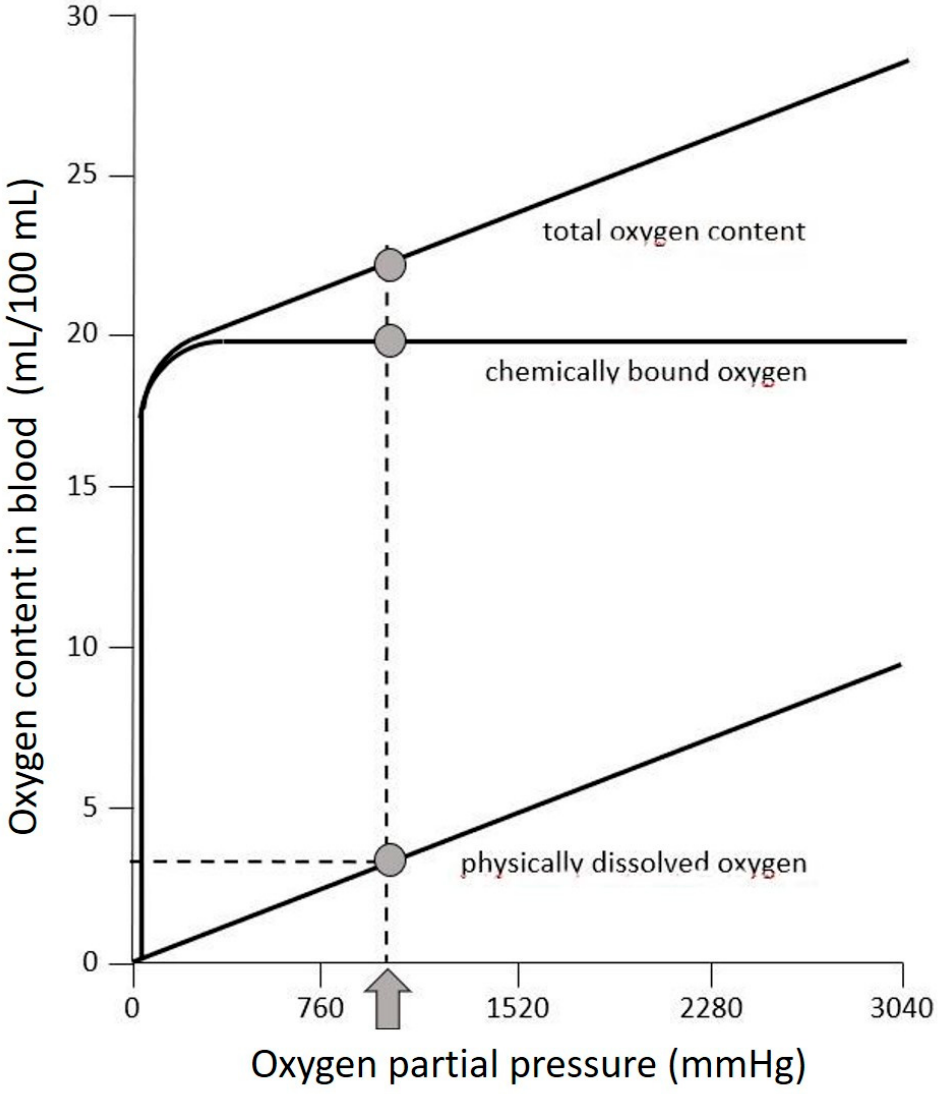
Figure 5. Oxygen hemoglobin dissociation curve for high O 2 partial pressures. The pO 2 in the present case was about 1050 mmHg, thus 3 mL O 2 /100 mL blood could physically be dissolved.